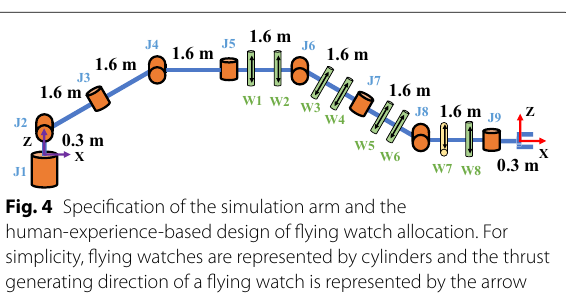
Fig. 4 Specification of the simulation arm and the human-experience-based design of flying watch allocation. For simplicity, flying watches are represented by cylinders and the thrust generating direction of a flying watch is represented by the arrow on the cylinder. J1,…,J9 are joint numbers and W1,…, W8 are flying watch